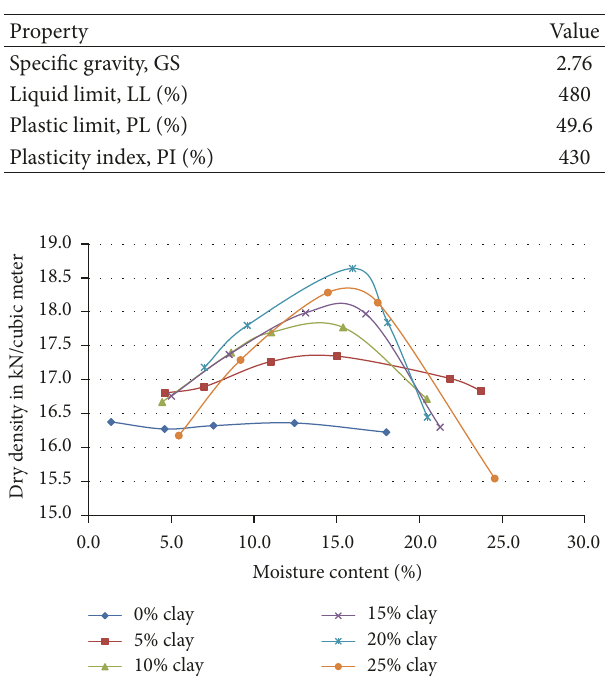
Table 3: Properties of HY OCMA bentonite.